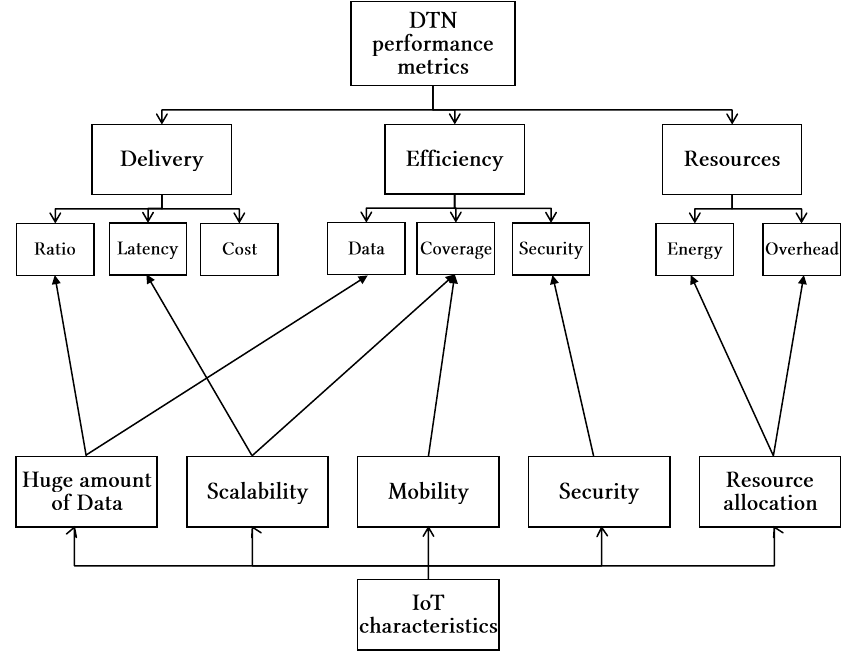
Figure 2. Dependency between DTN and IoT